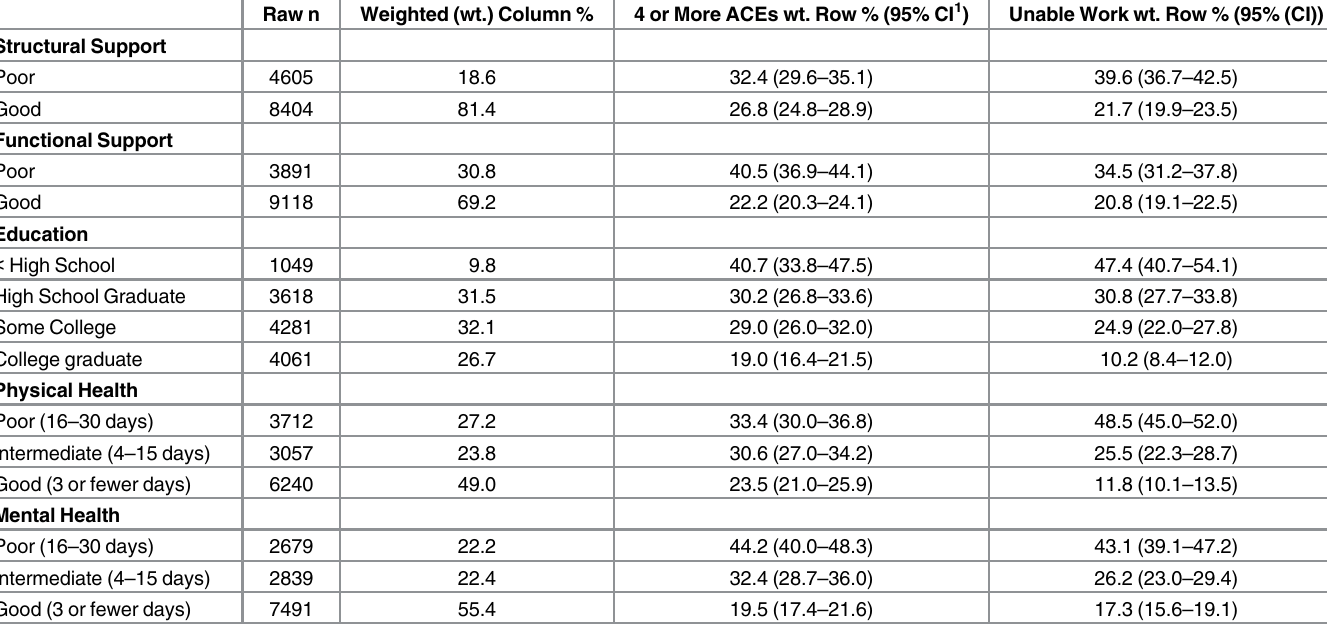
Table 4. Support, Recent Health and Education and Relationship to ACEs and Work Inability. Raw n Weighted (wt.) Column